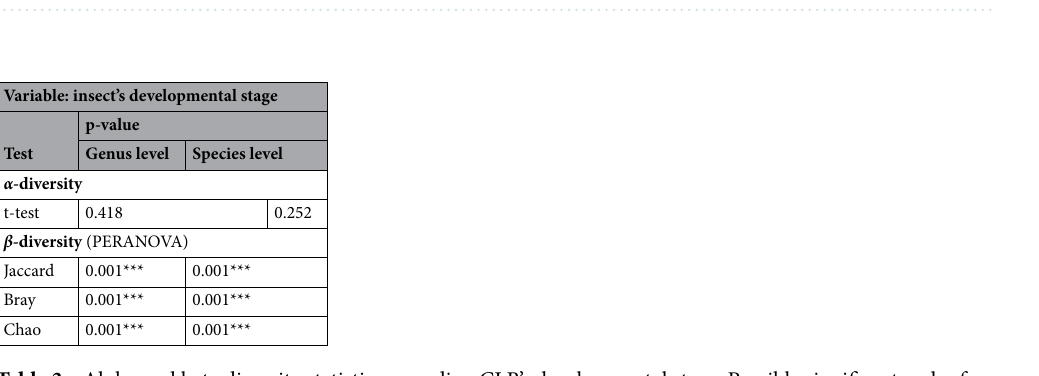
Table 2. Variable importance based on Pearson’s statistic used as a goodness of fit measure. Values represent the penalty for excluding selected variables. The higher penalty the more important variable.